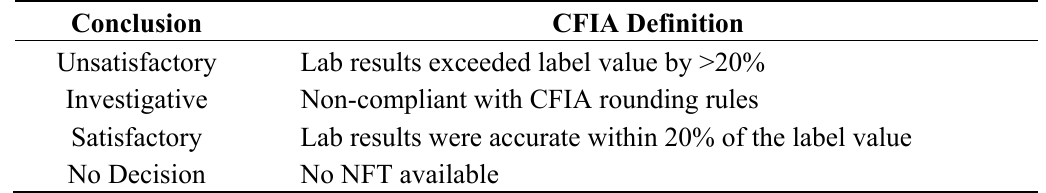
Table 1. The Canadian Food Inspection Agency (CFIA) compliance-based conclusions.